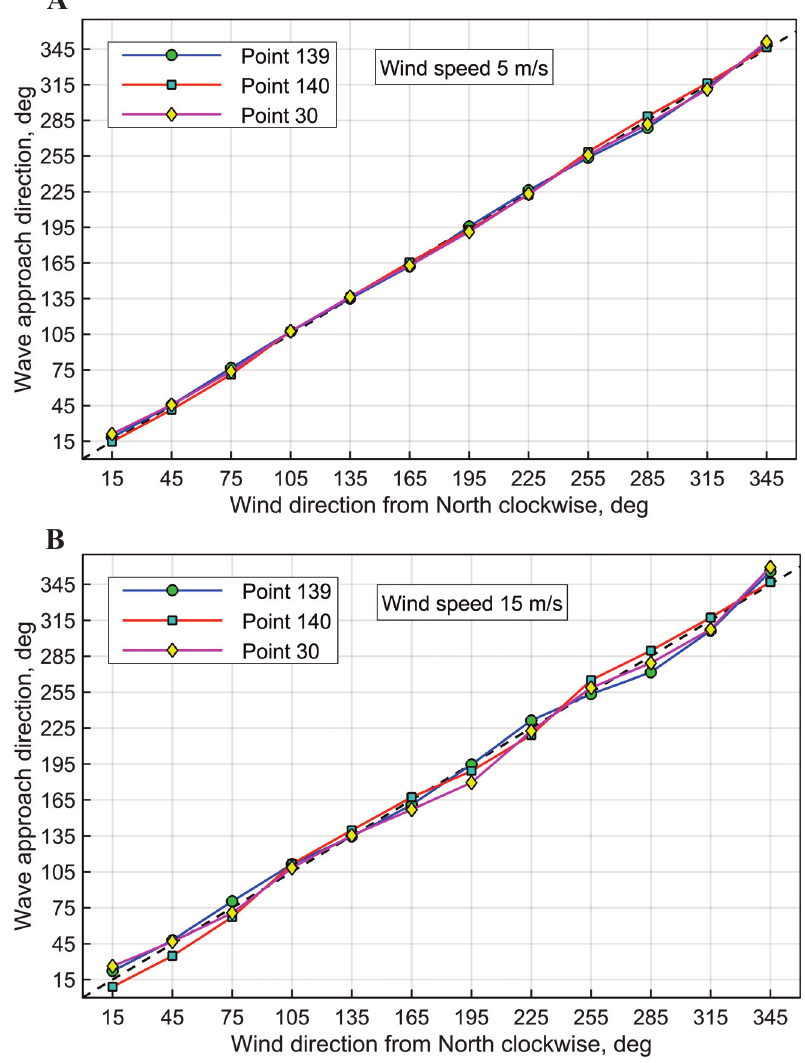
Fig. 5. Comparison of the wind direction and the mean propagation direction of simulated waves in saturated wave fields for wind speeds of 5 m/s (A) and 15 m/s (B) in the open part of the Gulf of Riga to the north (point 139, Fig. 1) and south (point 140, Fig. 1) of Ruhnu, and at the tip of Gretagrund (point 30, Fig. 4) to the south of